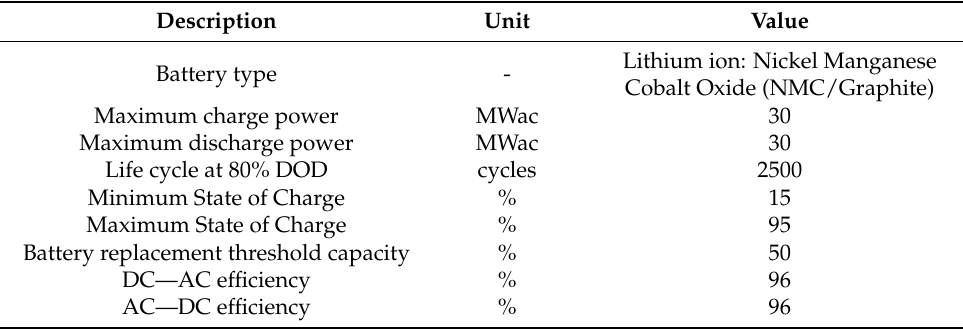
Table 8. Battery technical properties. Adapted from